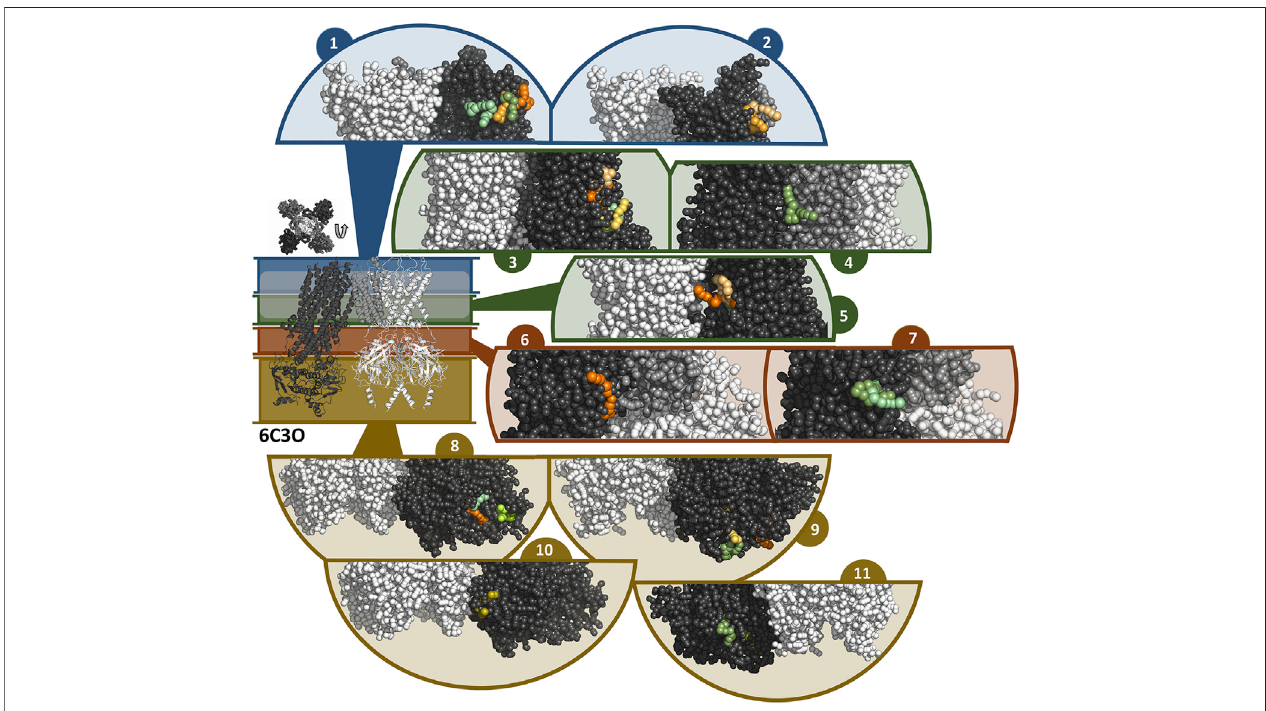
FIGURE 7 | Binding sites of travoprost and latanoprost found in a total of 60 μ s coarse-grained MD simulations with the 6C3O structure. The smaller fi gure on the leftshowstheoverallstructure ofthe6C3Ochannel,thelocationofthelipidbilayermembrane isindicatedwithawhitebar.Forthesakeofclarity,thestructureisdivided in different zones, which are shown in different colors (blue (cid:1) extracellular part as well as the outer lipid layer of membrane, green (cid:1) inner lipid layer of membrane, red (cid:1) cytoplasmic domain near cell membrane, yellow (cid:1) cytoplasmic domain). The fi gure above the overall structure shows the orientation of the SUR subunits in a top- down view of the channel. The different sub fi gures show close-ups of different interaction sites of the drugs to the channel. Travoprost is shown in shades of green, latanoprostinshadesoforangeandyellow.Ineachoftheclose-ups,allfour subunitsoftheK IR channelareshowncoloredinwhite.ForSUR, onlyonesubunitisshown. The TM0 of SUR colored in middle grey, while the rest of SUR is colored in dark